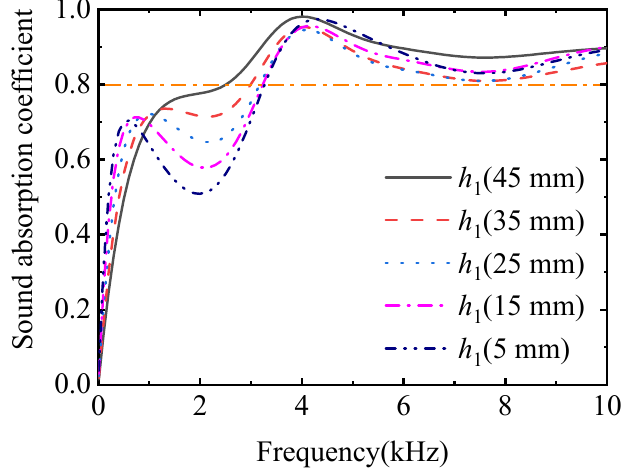
Figure 9. Comparison of α of SSC-HSH corresponding to different honeycomb heights.